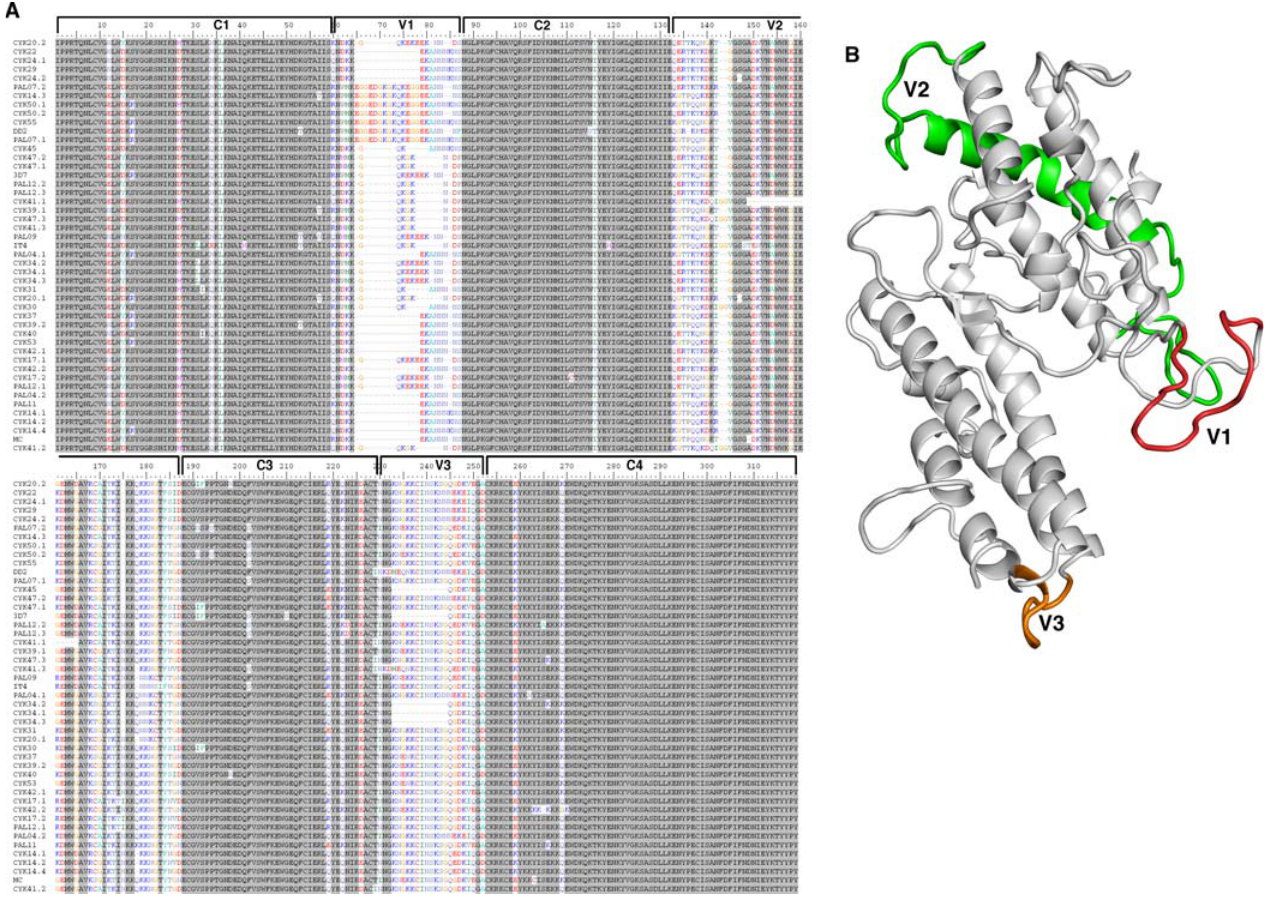
Figure 3. Multiple Alignment of VAR2CSA DBL3X Sequences (A) cDNA from 43 placental parasite samples were amplified with conserved DBL3X primers and sequenced. Sequences were curated for primer sequence, translated, and aligned. The text to the left indicates the identity of the samples. The DBL3X domain can be divided into four regions, which are highly conserved, C1–C4; and three regions, which are polymorphic and harbor deletions V1–V3. (B) Model of DBL3X showing the position of V1 (red), V2 (green), and V3